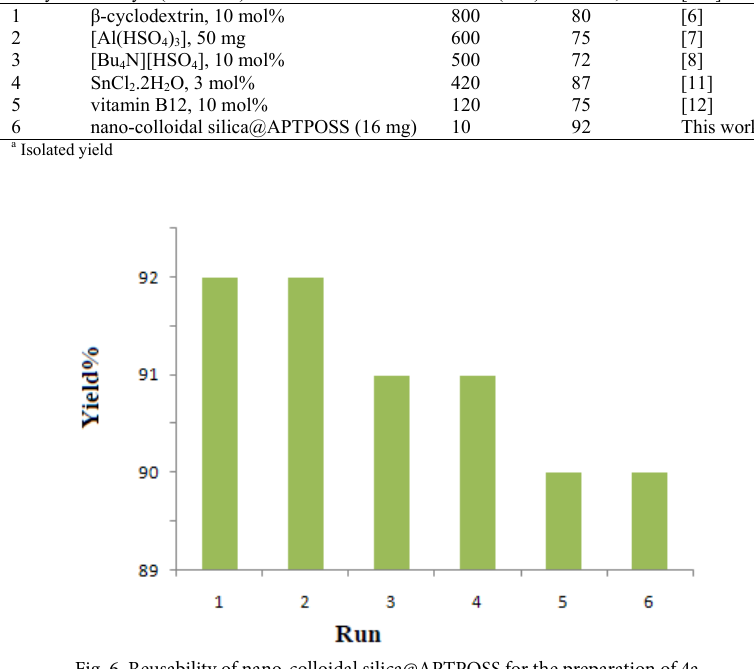
Fig. 6. Reusability of nano-colloidal silica@APTPOSS for the preparation of